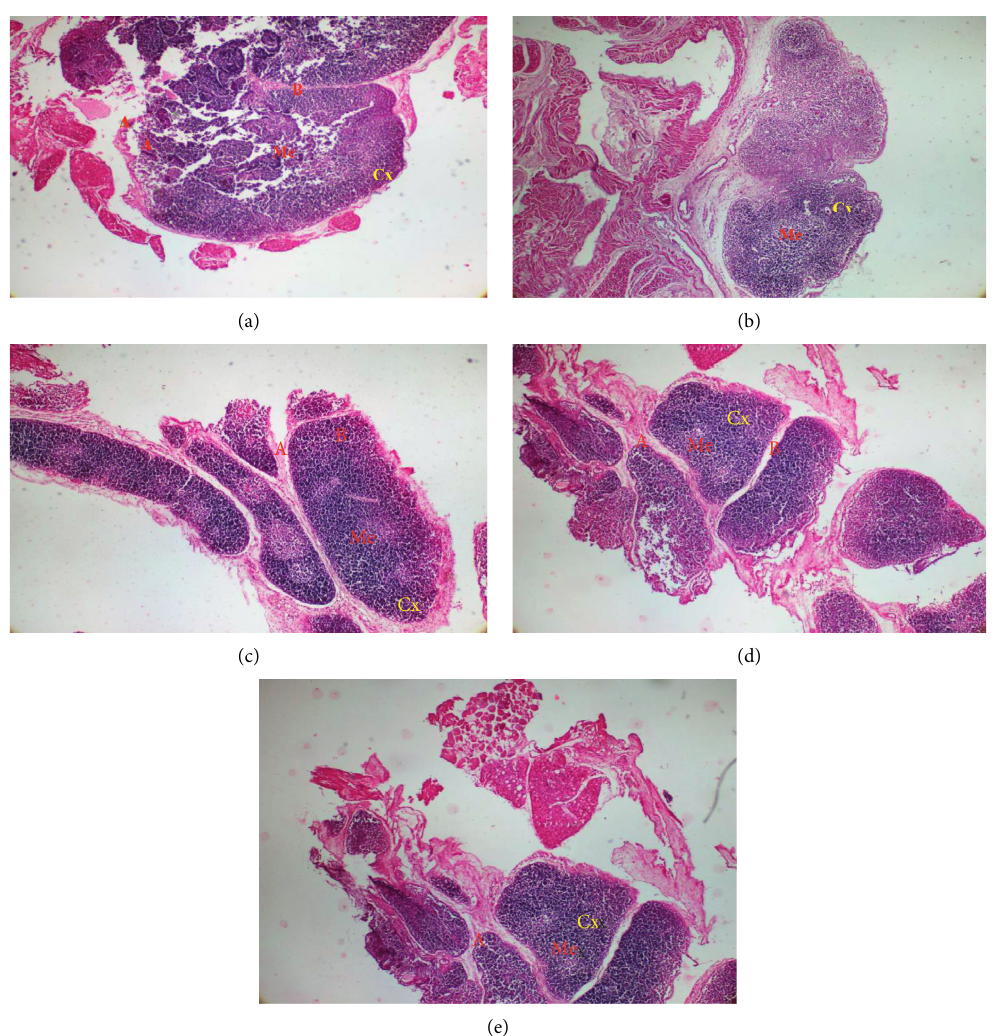
Figure 3: Microarchitecture of rat thymus of different groups (control and extract-treated groups). Normal group: untreated animals; negative: animals receiving methylprednisolone only. (a) Cross section in a rat thymus of normal group showing a lobule of the thymus with dense cortex (Cx), medulla (Me), interlobular (A), and intralobular (B) (H&E, X 100). (b) Cross section in a rat thymus of negative group showing the lobule of the thymus with less dense cortex (Cx) and the medulla (Me), interlobular (A), and intralobular (B) (H&E, X 100). (c) Cross section in a rat thymus of 25mg/kg-treated group showing the lobule of the thymus with dense cortex (Cx) and the medulla (Me), interlobular (A), and intralobular (B) (H&E, X 100). (d) Cross section in a rat thymus of 50mg/kg-treated group showing the lobule of the thymus with dense cortex (Cx) and the medulla (Me), interlobular (A), and intralobular (B) (H&E, X 100). (e) Cross section in a rat thymus of 100mg/kg-treated group showing the lobule of the thymus with very dense cortex (Cx) and the medulla (Me), interlobular (A), and intralobular (B). (H&E, X